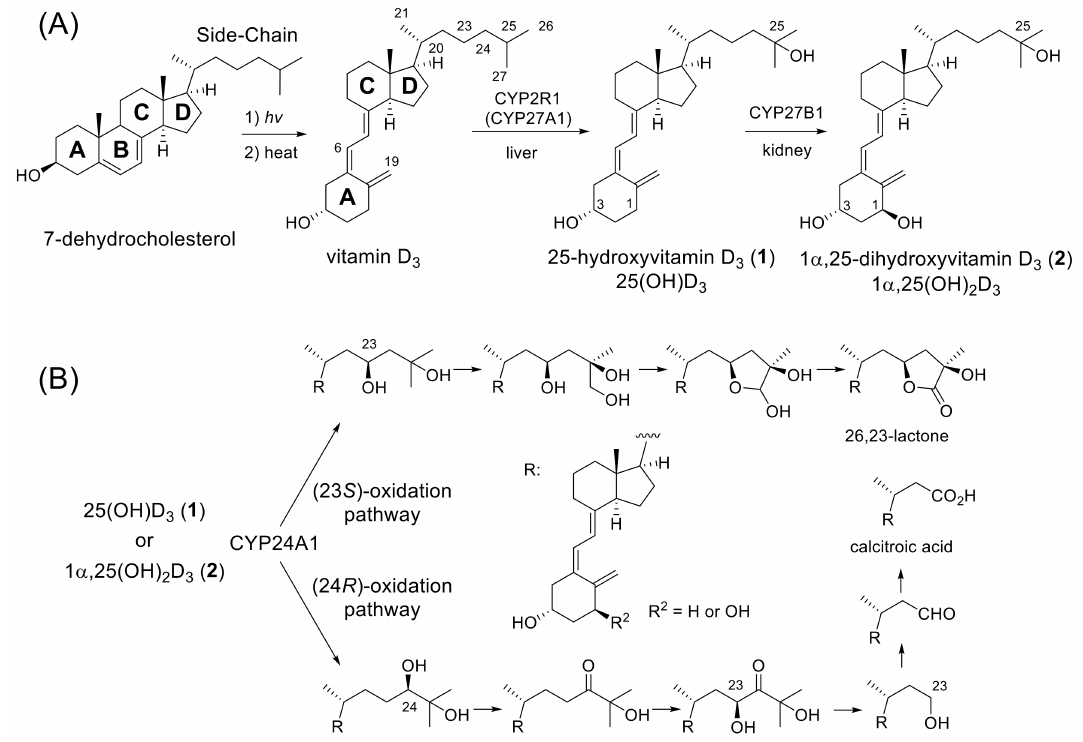
pathway to 25(OH)D 3 ( 1 ) and 1 α ,25(OH) 2 D 3 ( 2 ). ( B ) Deactivation pathways of 1 and 2 to 26,23-lactone and calcitroic acid through (23 S )-oxidation and (24 R )-oxidation,